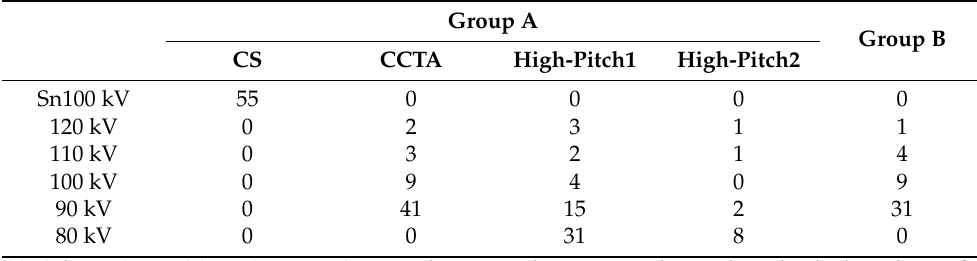
Table 1. Tube voltage distribution.